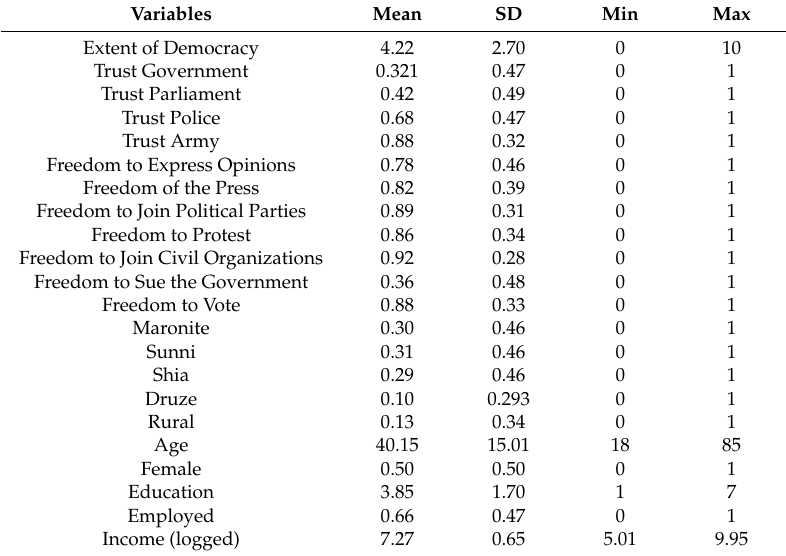
Table 2. Descriptive Statistics.